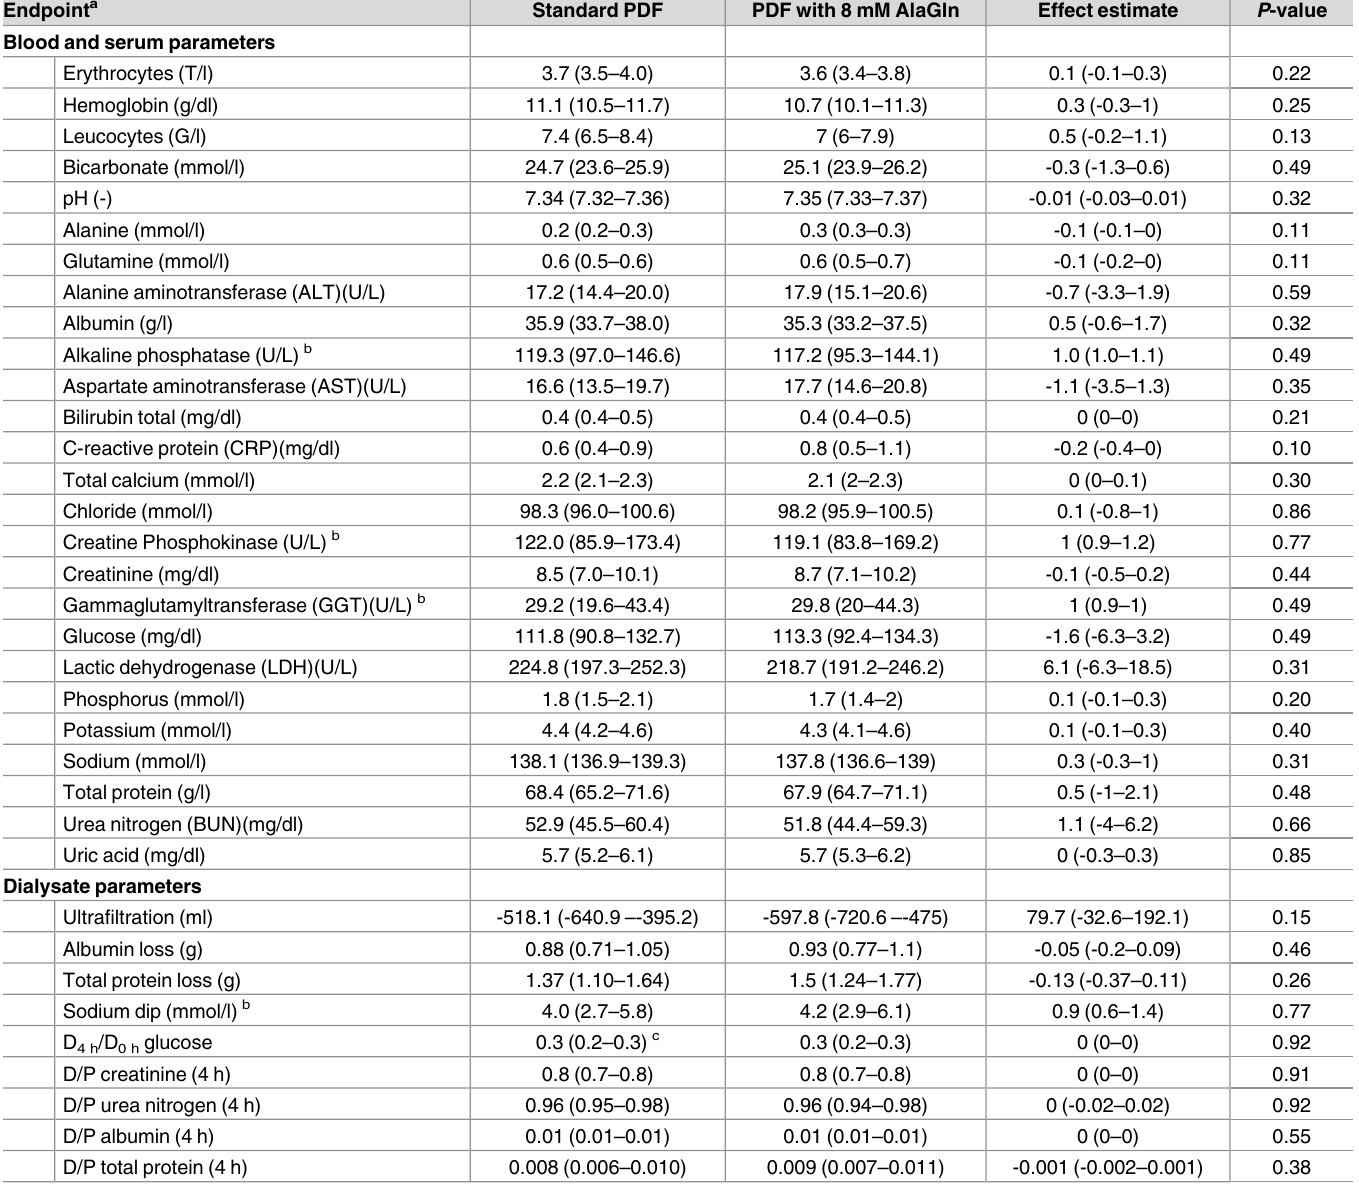
Table 2. Clinical routine and safety parameters in blood and